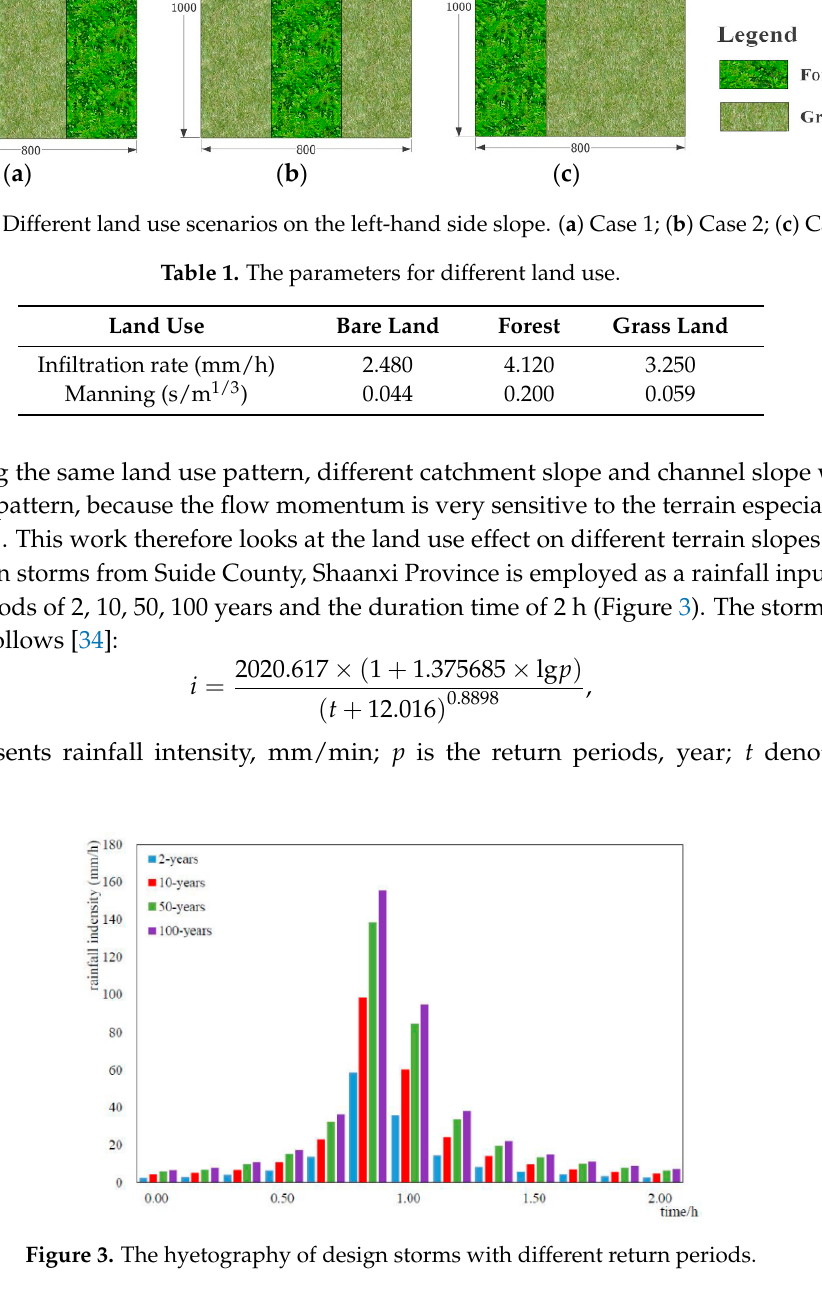
( b ) Figure 4. Comparison between the analytical and simulated hydrographs. ( a ) Side slope; ( b ) Channel. In this section, three land use factors are explored in detail: (i) channel slop ( i 1 ); (ii) side slope ( i 2 ) and (iii) vegetation cover patterns. 3.1. Land Use Effects on Flood Mitigation for Different Channel Slopes Three land use patterns in the V-shaped catchment with the side slope of 0.58 and four different channel slopes termed as i 1 of 0.01 (Scenario 1), 0.02 (Scenario 2), 0.05 (Scenario 3) and 0.08 (Scenario 4) are used in the simulation. As plotted in Figure 2, three land use patterns which divide a slope plane into three parts consisting of forest or grass land are employed in this section. The model is run under the rainfall condition with 4 return periods (2, 10, 50 and 100 years). The water depth and velocities are computed all over the domain and the flow discharge at the catchment outlet is recorded in this event. It should be noted that surface landform is not changed with the different land use patterns. Interception (accounting for a relatively small proportion) and the ecological restoration influence on channel morphology is not considered. The computed hydrographs at the outlet under different land use and slope scenarios are illustrated in Figures 5–8. The simulated peak discharges corresponding to the different land use scenarios exhibit high variations. The peak discharge among different land use cases (Case 1, Case 2 and Case 3) for different scenarios of channel slope are presented in Figure 9 and Table 2. For Scenario 1 ( i 1 = 0.01), the Case 2 shows more obvious effects in mitigating the peak discharge compared with the Case 1 and Case 3. The Case 3 has the highest peak discharge. The peak discharge of Case 2 can reduce by 7.02%, 3.94%, 4.22% and 4.19% for the rainfall events with different return periods, respectively, in contrast to Case 1. Comparing to Case 3, the peak discharge of Case 2 reduces by 19.58%, 15.15%, 13.52% and 12.94% for the rainfall events with different return periods, respectively. The same phenomenon can be observed for Scenario 2 ( i 1 = 0.02). The peak discharge reduction of Case 2 can reach 7.55–20.58%, compared to other land use types. However, for Scenario 3 ( i 1 = 0.05), the results clearly demonstrate that the Case 3 mitigates the peak discharge in a most efficient way.